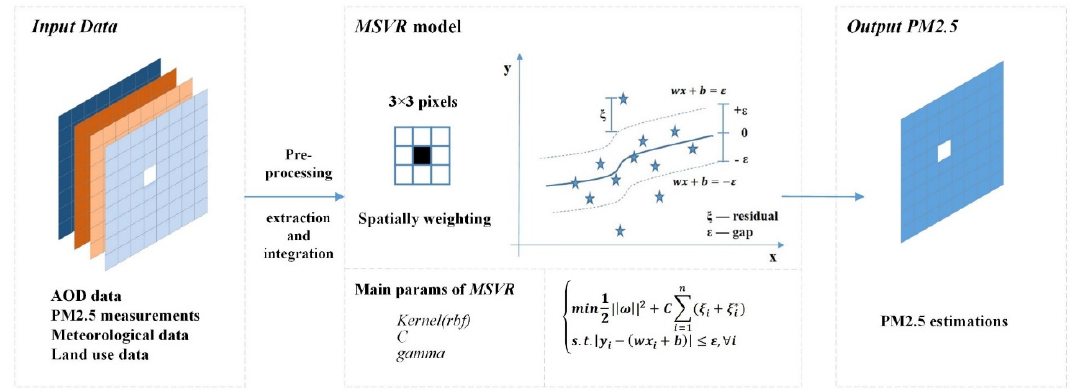
Figure 2. The main structure of the MSVR model.